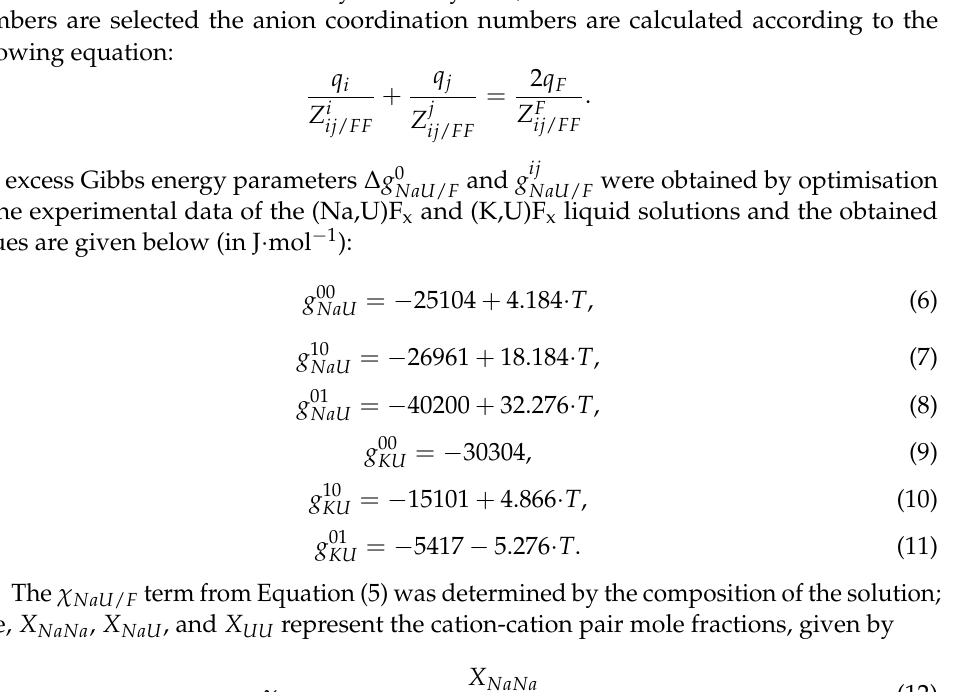
, for the mixing cations i and j used for the thermo- ij